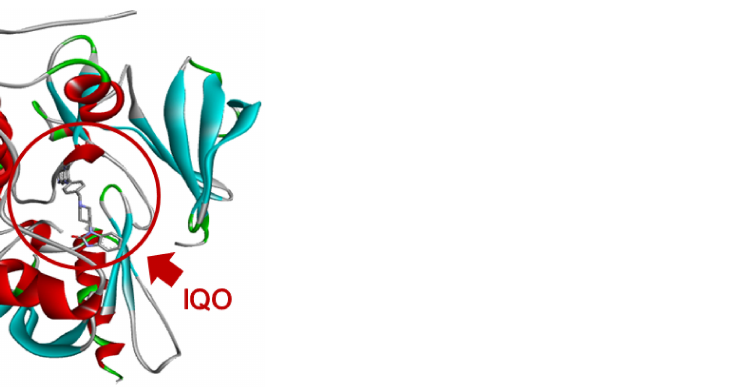
Figure 1. AKT1 structure with the IQO inhibitor. The image shows the global architecture of AKT1 and the IQO inhibitor position. The backbone of AKT1 is shown with red ribbons and cyan arrows to indicate helices and strands, respectively. The IQO molecule is represented in the stick mode, and its position is highlighted with the red circle.